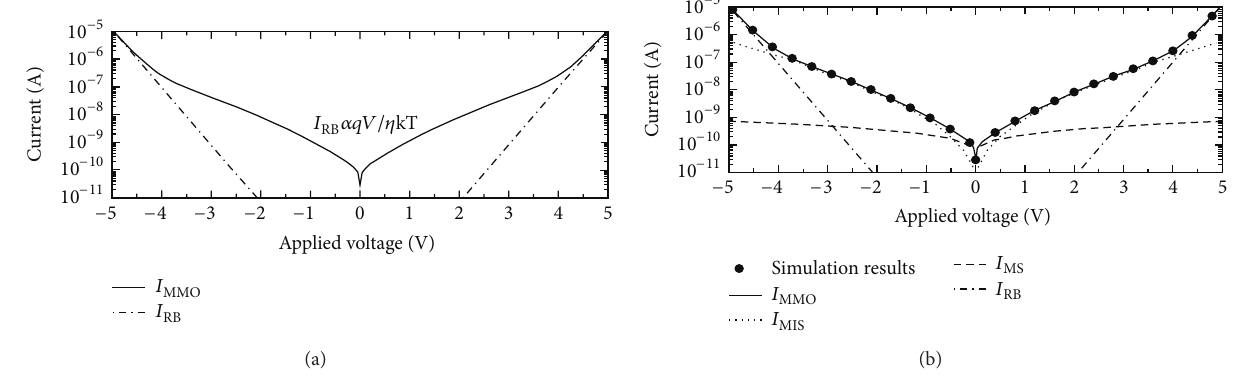
Figure 4: Band diagram under a larger applied voltage.